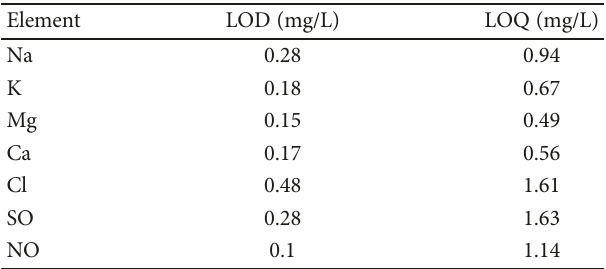
Table 3: Detection limit (LOD) and quantitation limit (LOQ) of the major element concentrations.